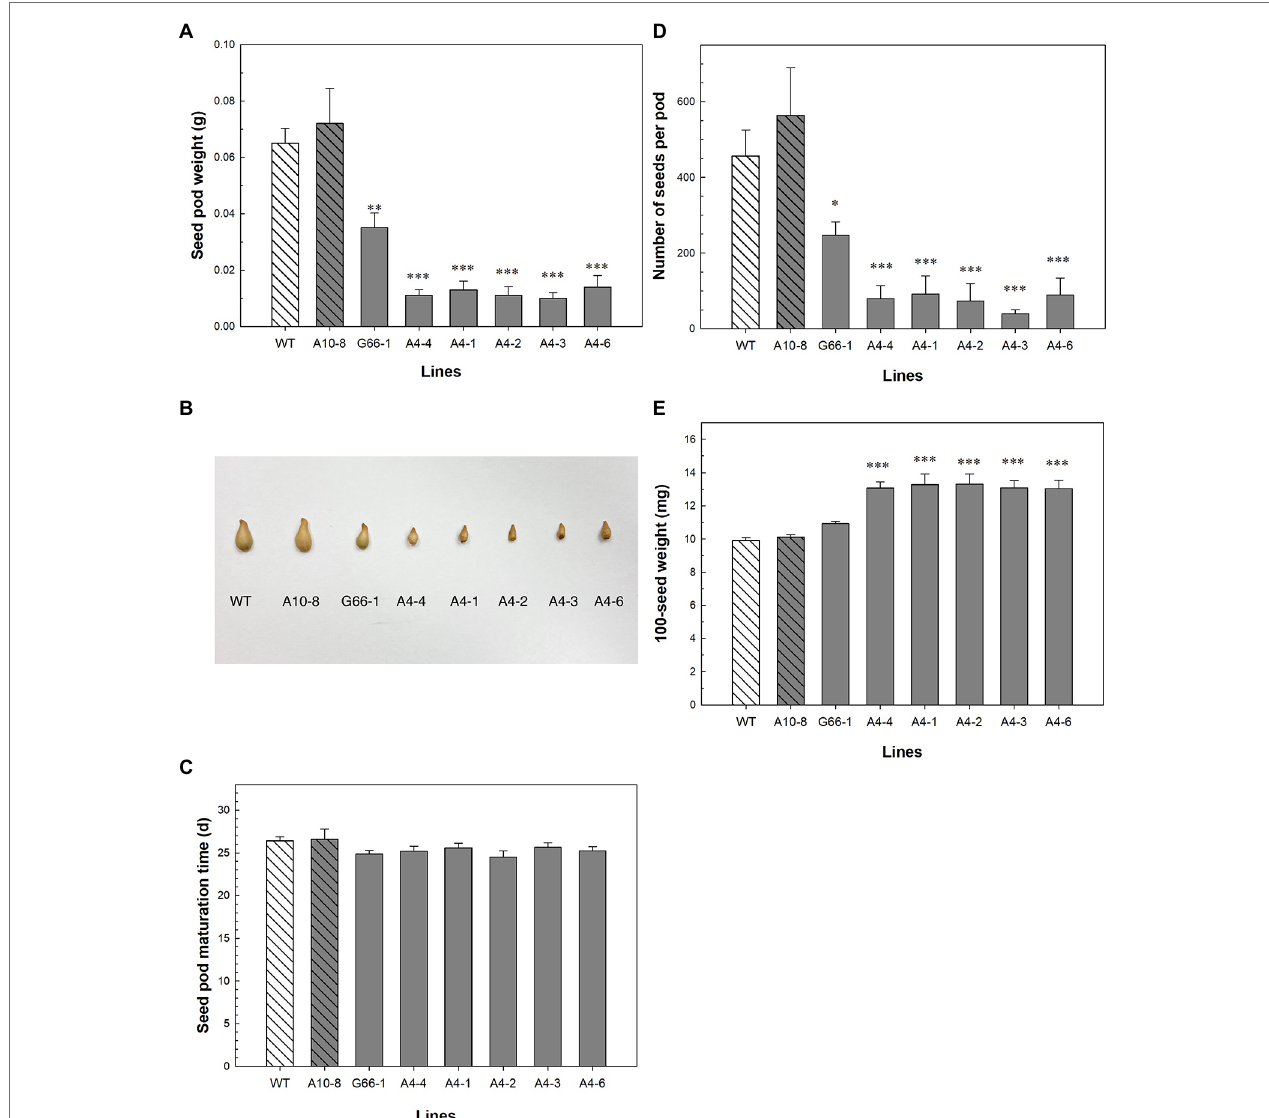
FIGURE 4 | Seed phenotypic evaluation of Petunia × hybrida ‘Mitchell Diploid’ wild-type plant (WT), non-mutated regenerated line A10-8, and PhATG6 -KO lines. (A) Capsule weight ( n = 3). (B) Picture of representative capsules. (C) Capsule maturation time ( n = 8). (D) Number of seeds per capsule ( n = 3). (E) 100-seed weight ( n = 4). Bars represent the means of the measurements ± standard error, and bars with stars indicate a significant difference compared to the WT: “***” p ≤ 0.001, “**” p ≤ 0.01, “*” p ≤